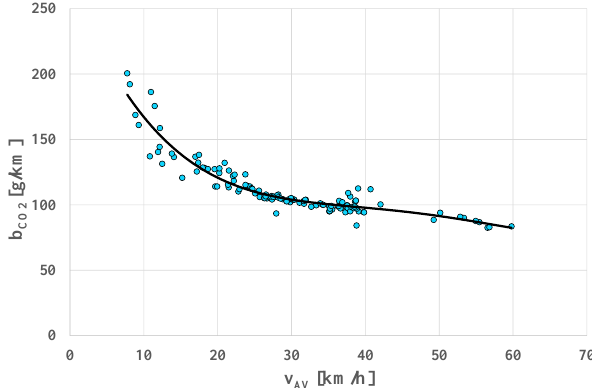
Fig. 13. Dependence of the average specific distance emission of carbon monoxide on the average vehicle velocity in the Malta tes